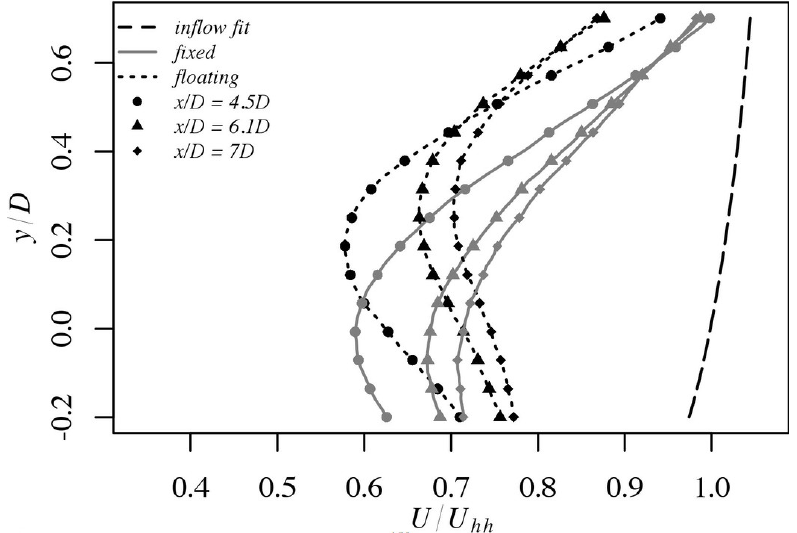
Figure 5. Profile of a logarithmic fit to inflow and far wake profiles of U/U and floating case at downstream distances 4.5 D , 6.1 D and 7 D